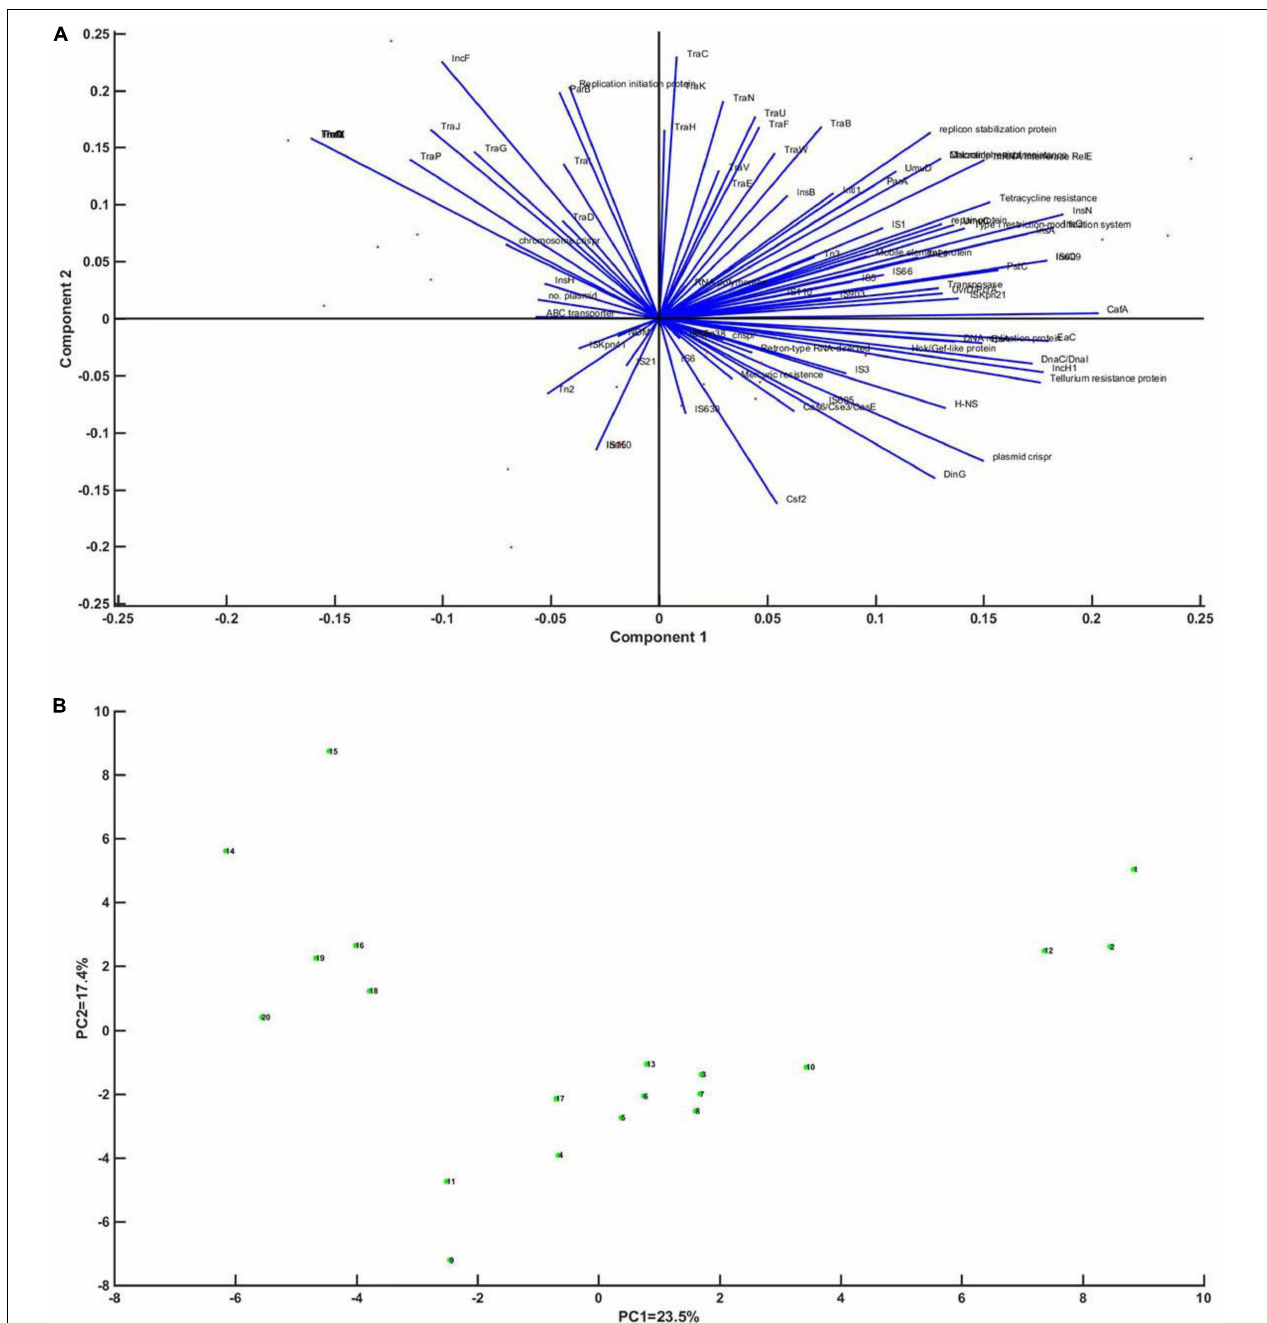
FIGURE 6 | Principal component analysis of the CRISPR plasmid of Klebsiella with mobile genetic elements, regulatory factors, and enzymes of DNA metabolism. (A) Correlation vector diagram of principal component axis (blue line) and each factor of Klebsiella strain (red dot). The vector represents the correlation of each factor to the axis of the first principal component. Panel (B) represents an enlarged view of Klebsiella ’s